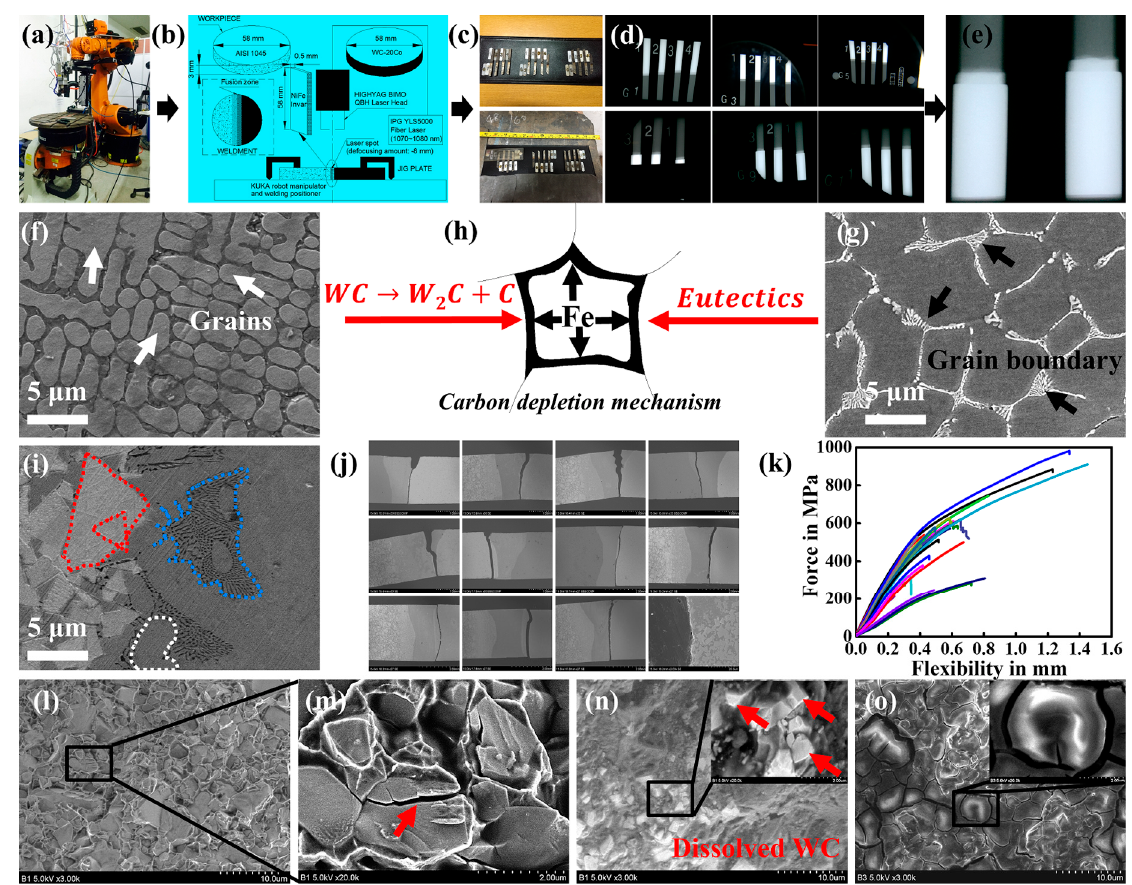
Figure 5. Laser welding of WC–Co cemented carbide and AISI 1045 steels. ( a ) Robotic welding systems for welding of cemented carbide and carbon steel. ( b ) Architecture of the preparation of WC–20Co / Invar / AISI 1045 welded joint: dimensions of φ 58 × 3 mm base metal, interlayer: 0.5 mm thick Invar. ( c ) X-ray nondestructive testing (NDT) of as-welded specimens. ( d ) X-ray detection film maps. ( e ) Image processing showing the weld defect. ( f , g ) Grains and grain boundaries in the fusion zone. ( h ) Carbon depletion mechanism during welding. ( i ) Microstructures showing the grain growth and mixed carbide near the WC–Co / Invar interface. ( j ) Bend strength. ( k ) Face bend-tested specimens showing the fracture propagation path. ( l – o ) Bend fracture surface showing the interdendritic fracture in the fusion zone and transgranular fracture in the heat-a ff ected zone (HAZ). Adapted from [68], with permission from Elsevier, 2016.